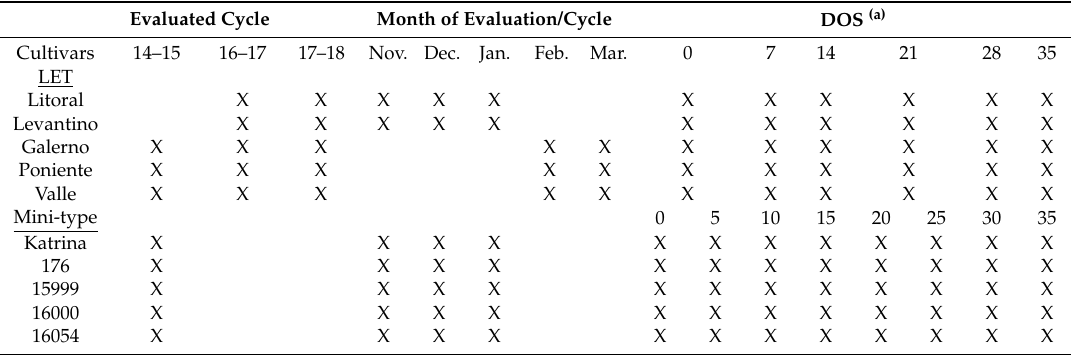
Table 1. Sampling for each crop cycle and month of evaluation and days in which the samples of each cucumber cultivar were measured in the